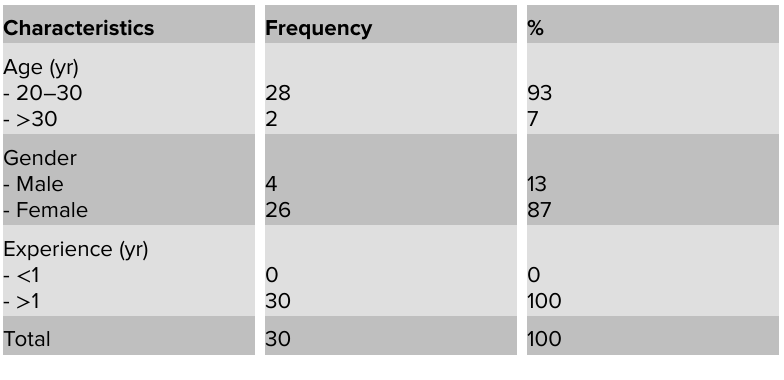
TABLE 1: Distribution of the study subjects according to their demographic background ( n =30).